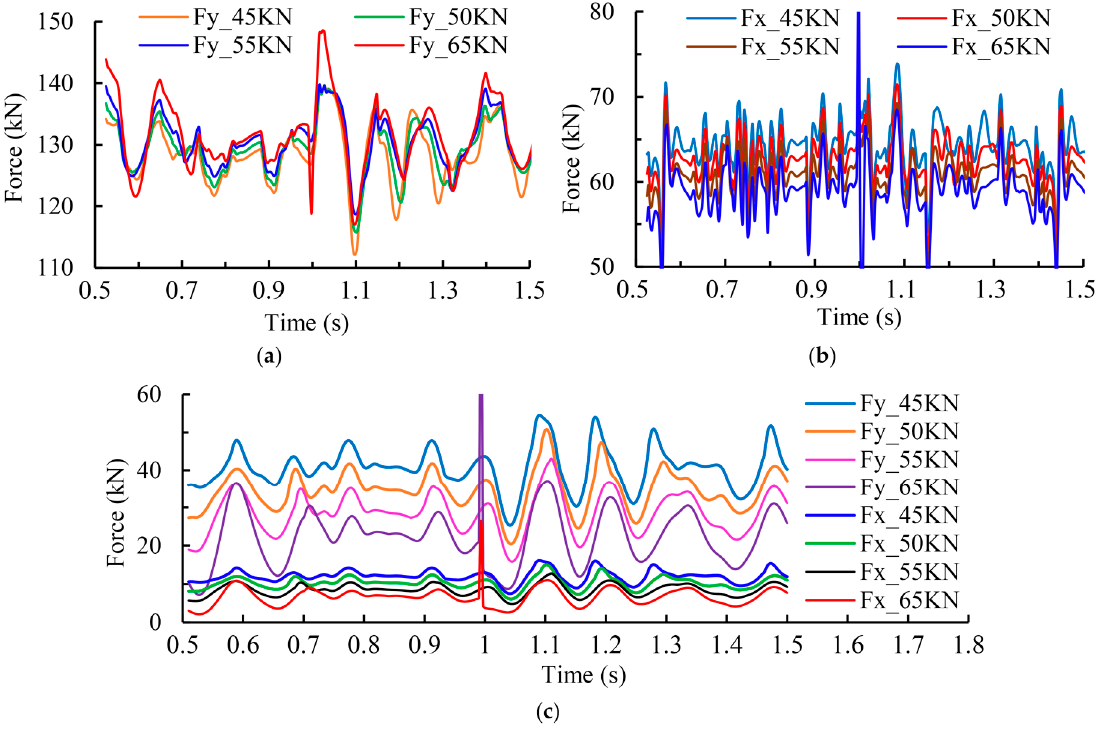
Figure 7. Mechanical property of the traction unit under different cutting force: ( a ) The y-direction force of the walking wheel; ( b ) The x-direction force of the walking wheel; and ( c ) The force of the support slipper.